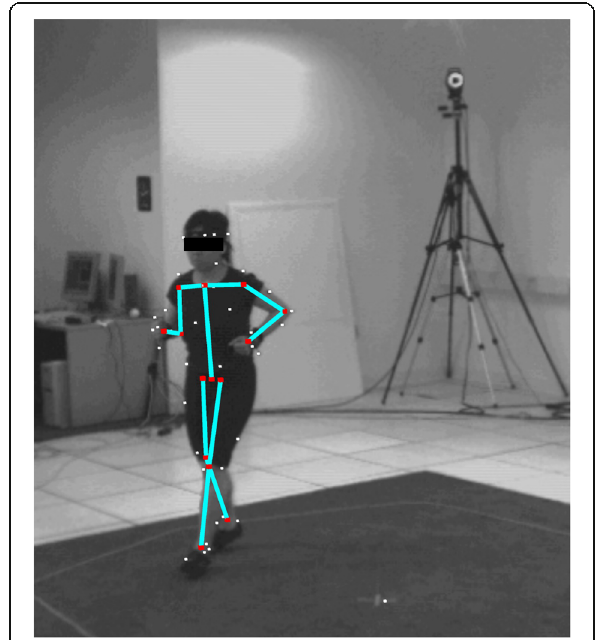
Fig. 8 An example image from the HumanEva dataset used to validate markerless systems within computer vision. White dots indicate the location of tracked reflective markers and the cyan lines represent the defined skeleton model fit to the marker data. Although useful as an early benchmark for markerless tracking systems, the dataset has clear limitations for assessing the quality of any markerless tracking results, especially in the context of biomechanics. Notice that the markers are attached to clothing, marker clusters are not utilised, and the joint centres inferred from the fitted skeleton are not closely aligned with how the person appears in the image (e.g. right elbow and hip joints). See further information in the